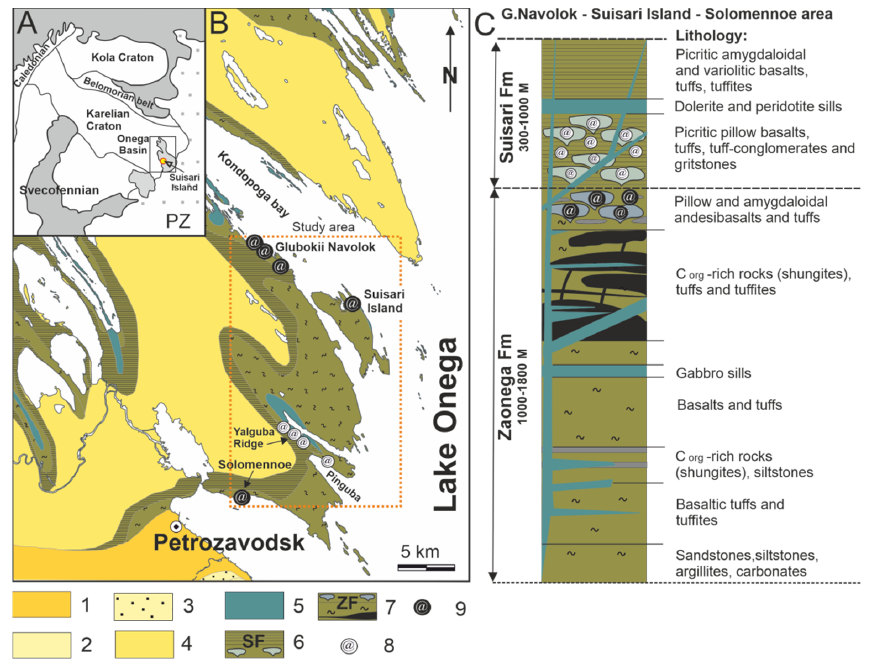
Figure 1. Location of sampling areas ( A ) and simplified geological map of the north-western part of the Onega Basin, Karelian Craton ( B ). Legend: Neoproterozoic: 1—ca. 635–542 Ma sandstones, siltstones, argillites, conglomerates. Paleo- proterozoic: 2—ca. 1800–1650 Ma red quartzitic sandstones, quartzites, conglomerates; 3—ca. 1920–1800 Ma grey sand- stones, siltstones, argillites, conglomerates; 4—quartzitic sandstones; 5—ca. 1975–1956 Ma gabbroids. Ludicovian Super- horizon, ca. 2100–1920 Ma: 6—picrites, picritic basalts, tuffs, tuffites, tuff-conglomerates, gritstones (Suisari Formation); 7—C org -rich rocks (shungites), sandstones, siltstones, argillites, carbonates, basalts, andesibasalts, tuffs, tuffites (Zaonega Formation); 8—light-coloured agate occurrences; 9—black agate occurrences. ( C ) Simplified geological section of the stud- ied